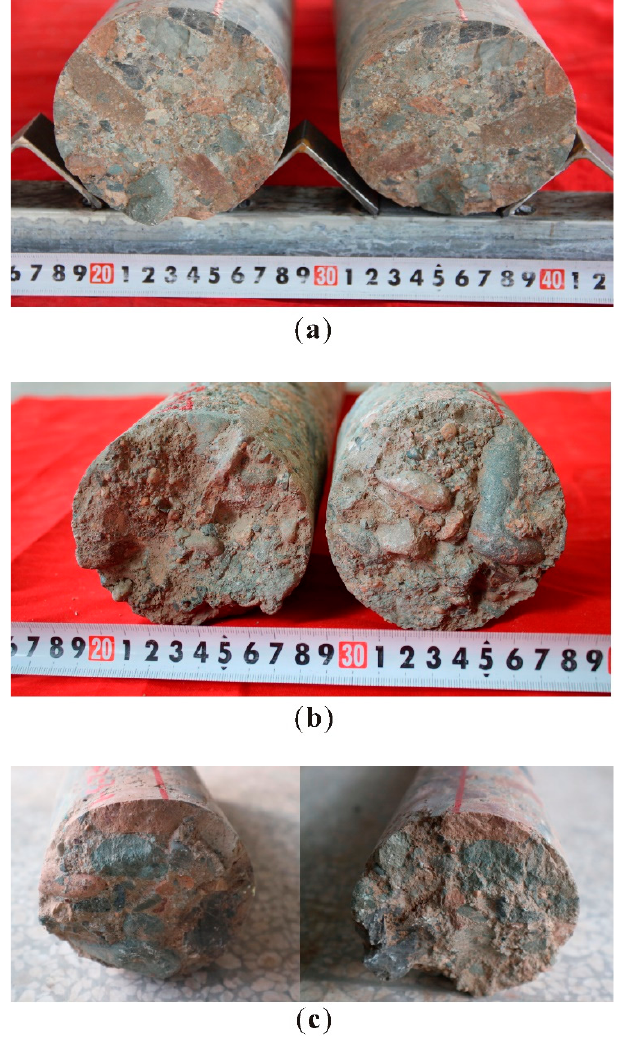
Figure 6. Surface character of hydraulic fractures. ( a ) Through-penetrating gravel surfaces, planar surface with split gravel. ( b ) Bypassing gravel surfaces, uneven surface with raised unbroken gravel. ( c ) Bypassing gravel and through-penetrating gravel occur in a single surface.